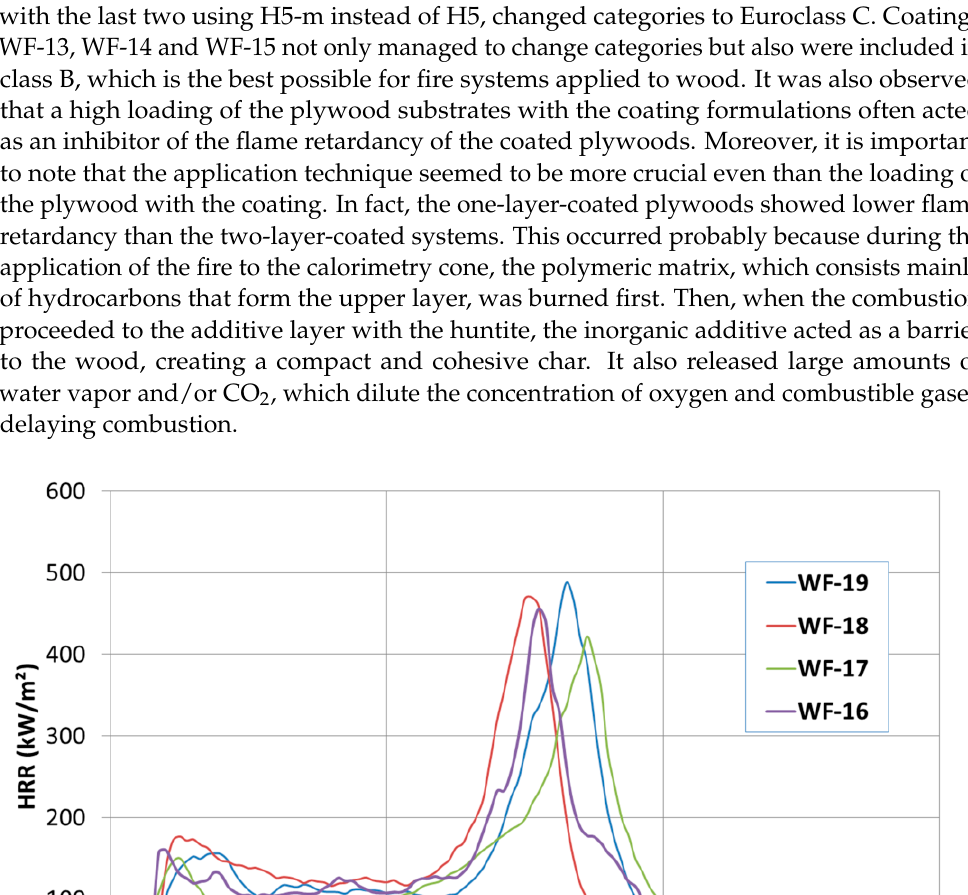
Figure 10. Heat Release Rate (HRR) curves vs. time in the cone calorimeter ISO 5660-1 for coatings WF-16, WF-17, WF-18 and WF-19.